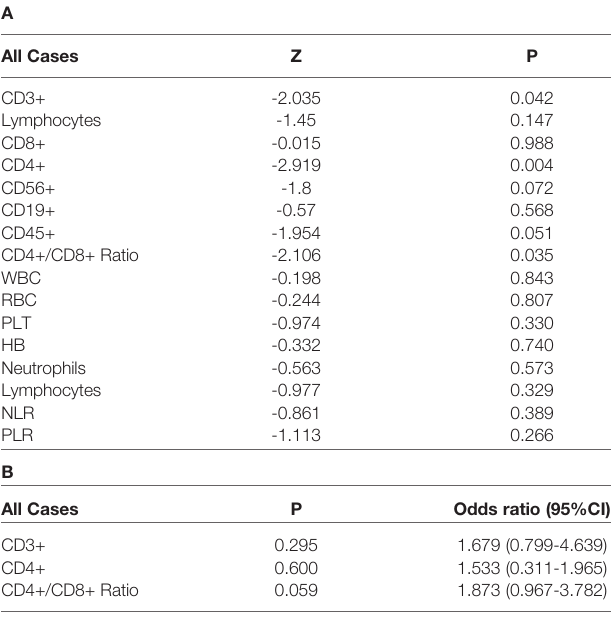
TABLE 2 | Univariate ( A ) and multivariate analysis ( B ) for correlation of circulating lymphocytes with therapy response in TNBC.